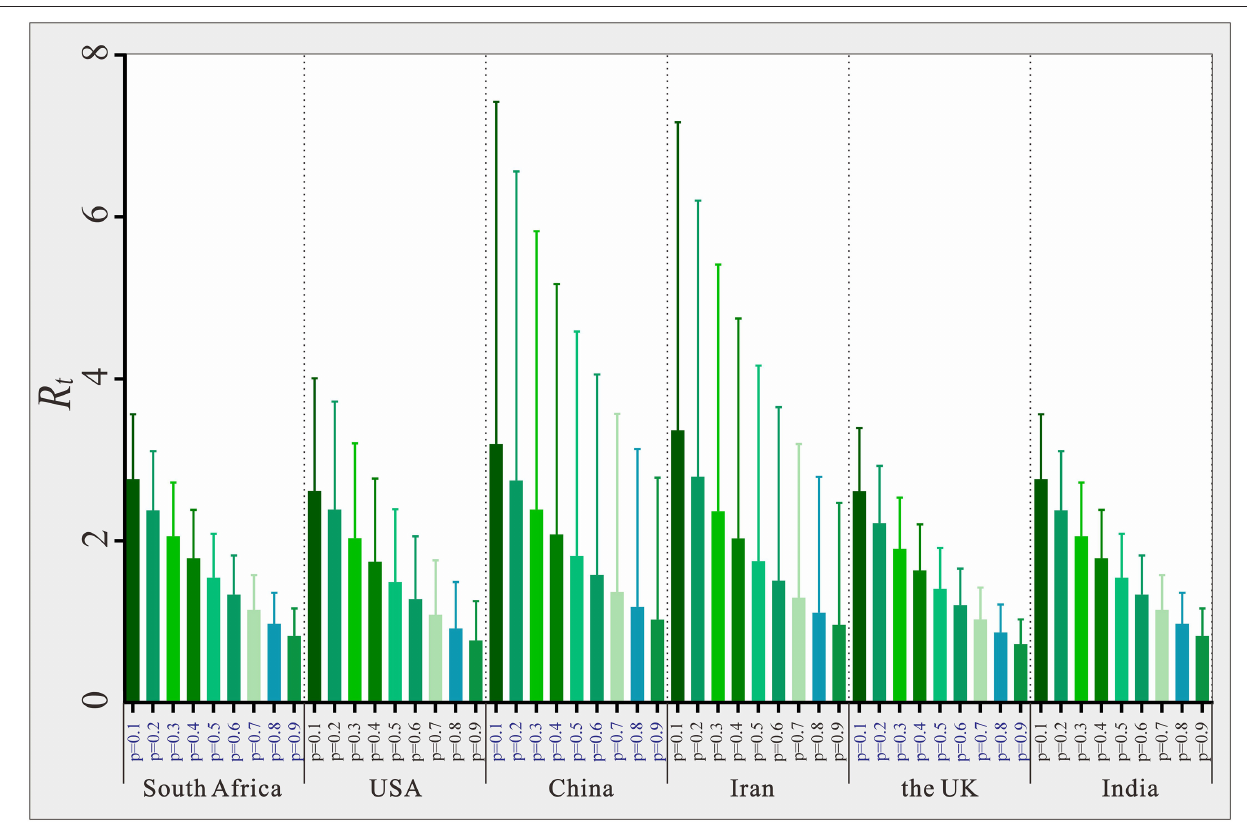
FIGURE 9 | Estimated R t value based on different p in six selected countries in six WHO